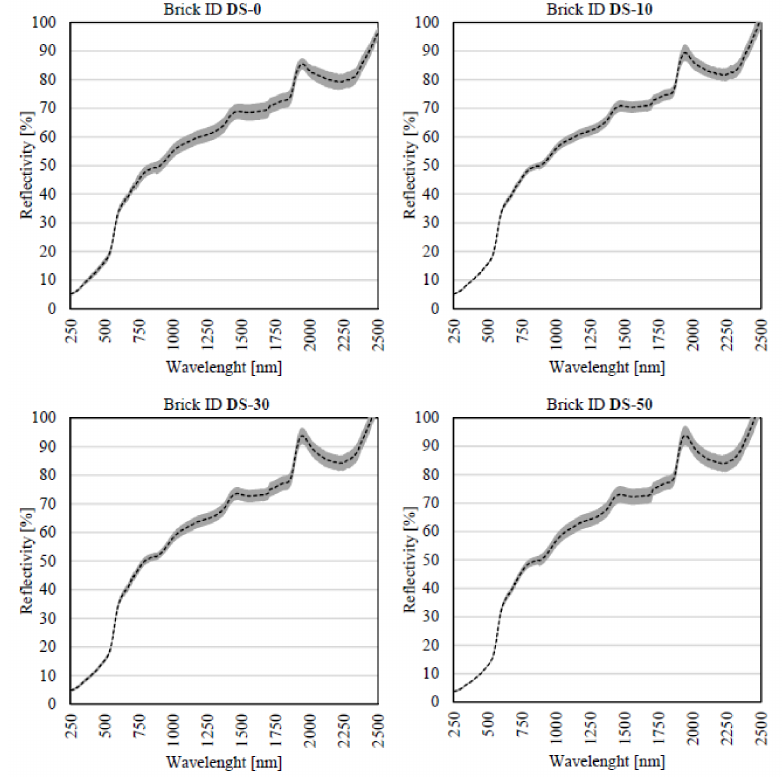
Figure 6. Spectral reflectance measured for the four brick